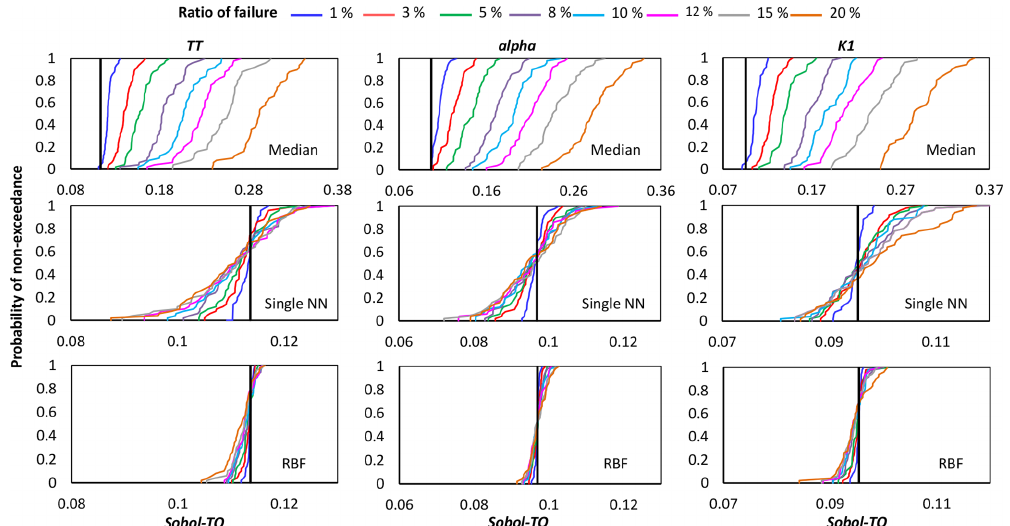
Figure B2. Comparison of the proposed crash-handling strategies in a sensitivity analysis of the HBV-SASK model using the variance- based algorithm for different ratios of failure. The CDFs of the sensitivity indices for moderately influential parameters { TT , alpha , K1 } are compared in this plot. The vertical line (solid black) on each subplot represents the corresponding “true” sensitivity index obtained when there were no failures.